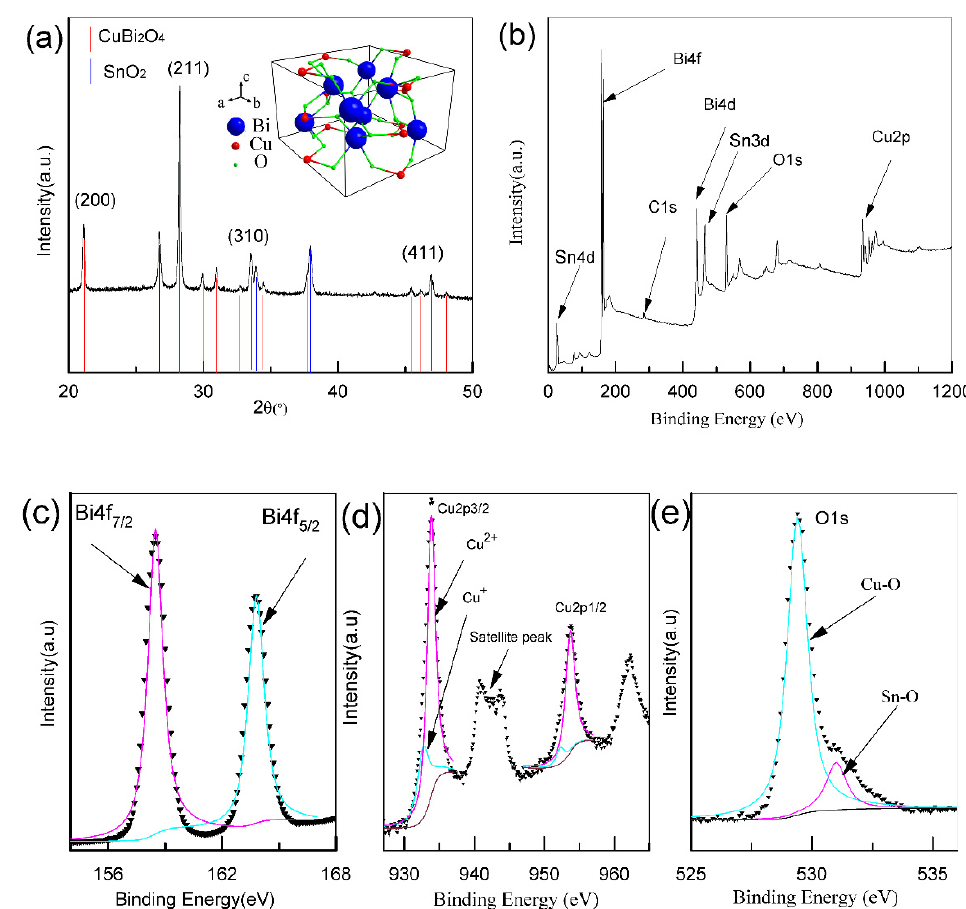
Figure 3. XRD pattern ( a ); XPS spectrum ( b ); high-resolution XPS spectra for ( c ) Bi4f; ( d ) Cu2p; and ( e ) O1s.